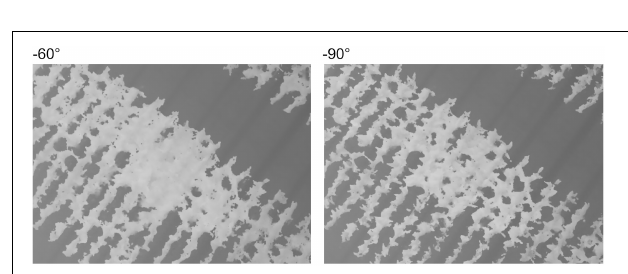
FIGURE 7 | A comparison of DSMs with − 60 ◦ and − 90 ◦ for the camera angle. The DSMs are shown in grayscale; when the pixel is white, the altitude is